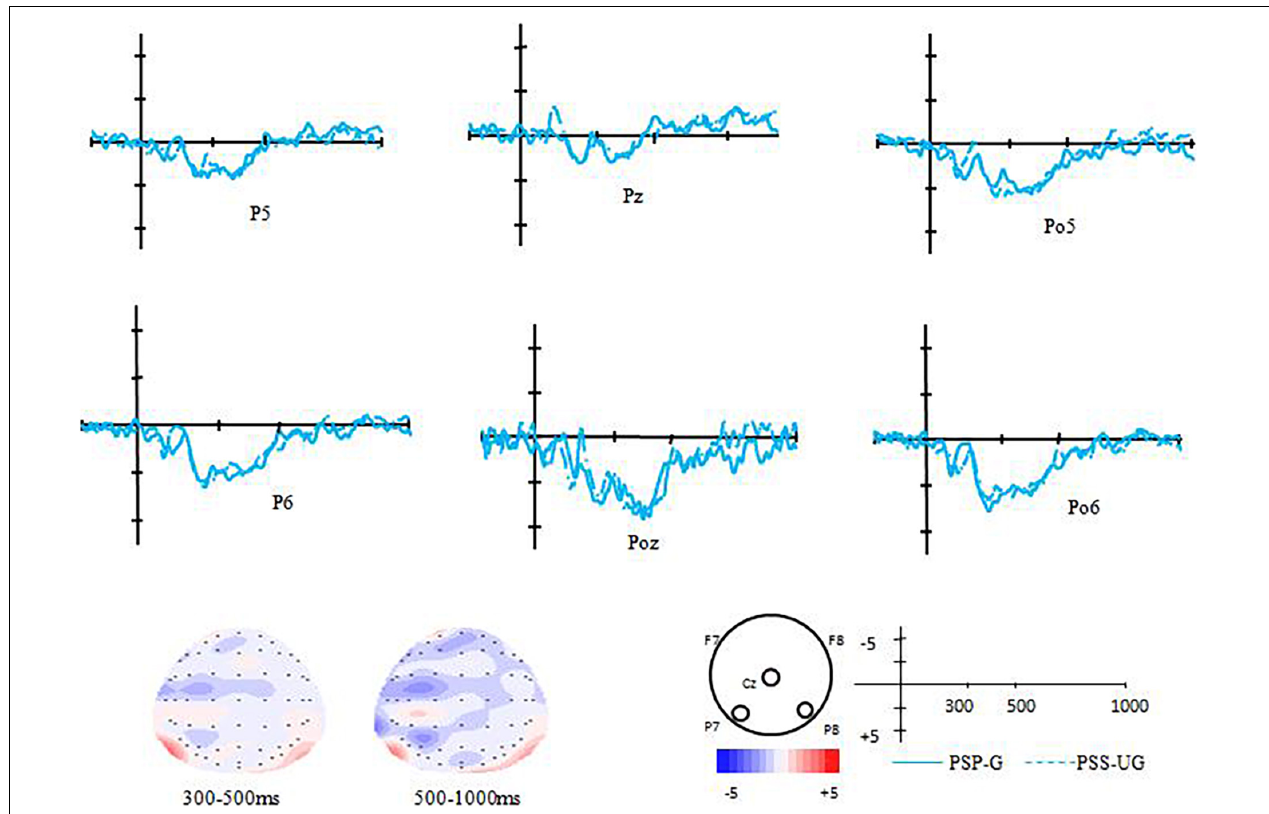
FIGURE 2 | Voltage maps and the grand average ERPs of the CG for the difference between correct and violated sentences in the transfer-effect